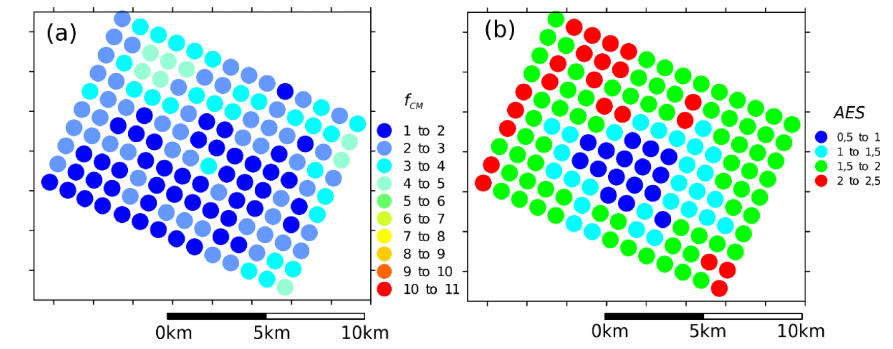
Figure 8. Test case 2: spatial distribution of (a) the mean and (b) the performance index AES from the updated f CM ensemble after data assimilation.